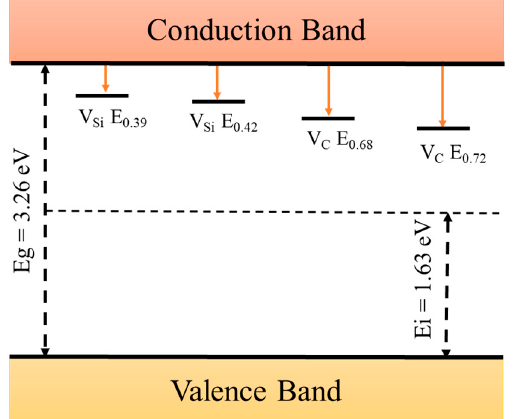
Figure 8. Band diagram and capture of carriers in 4H-SiC diodes after proton irradiation.